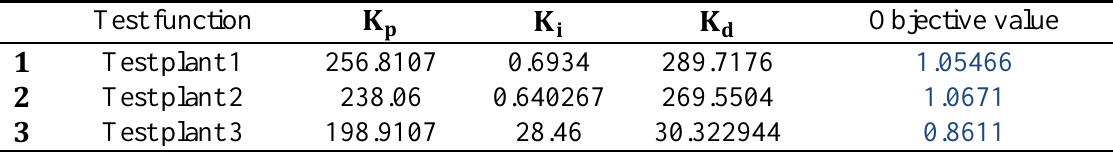
Table 2. The optimal values of objective function and PID